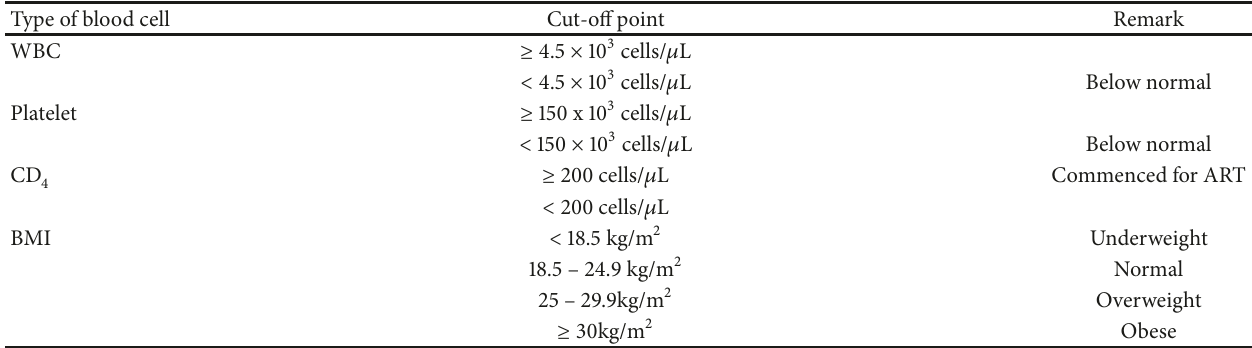
Table 1: Cut-off point for blood cells considered in the